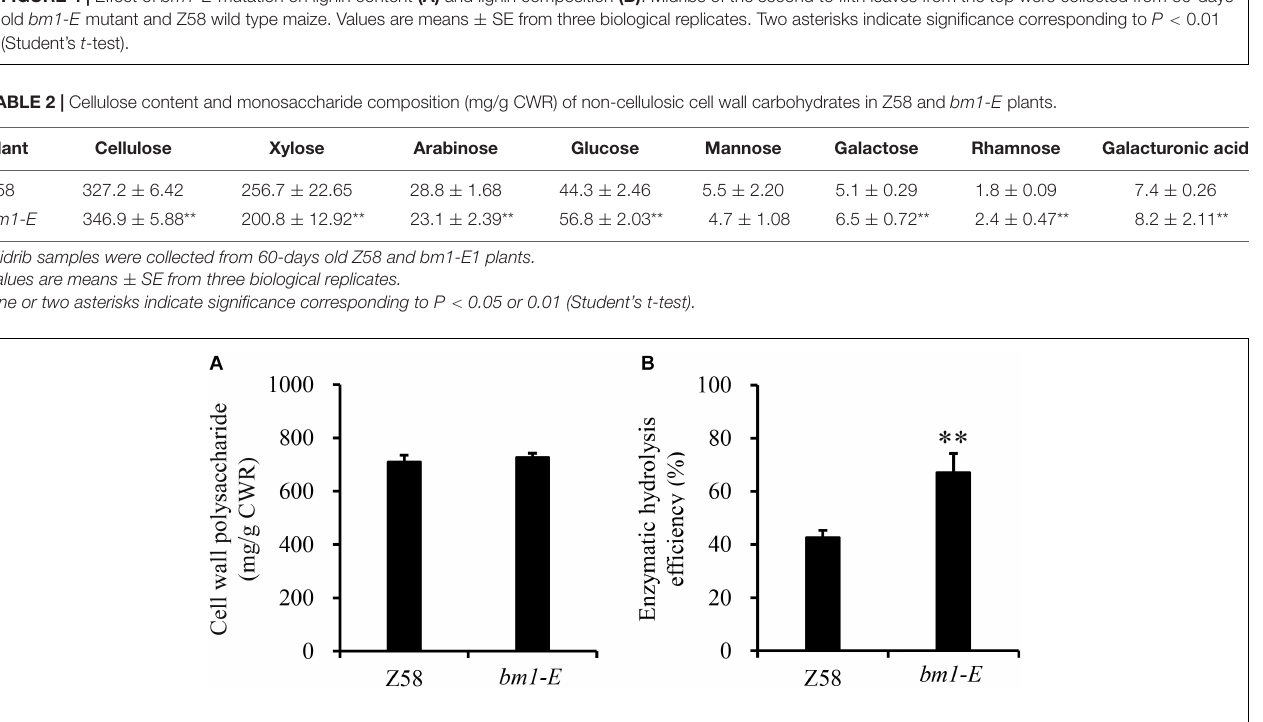
FIGURE 5 | Effect of bm1-E mutation on total sugar content (A) and enzymatic hydrolysis efficiency (B) . Stalk samples were collected from 90-days old bm1-E mutants and Z58 wild type plants. Values are means ± SE from three biological replicates. Two asterisks indicate significance corresponding to P < 0.01 (Student’s t